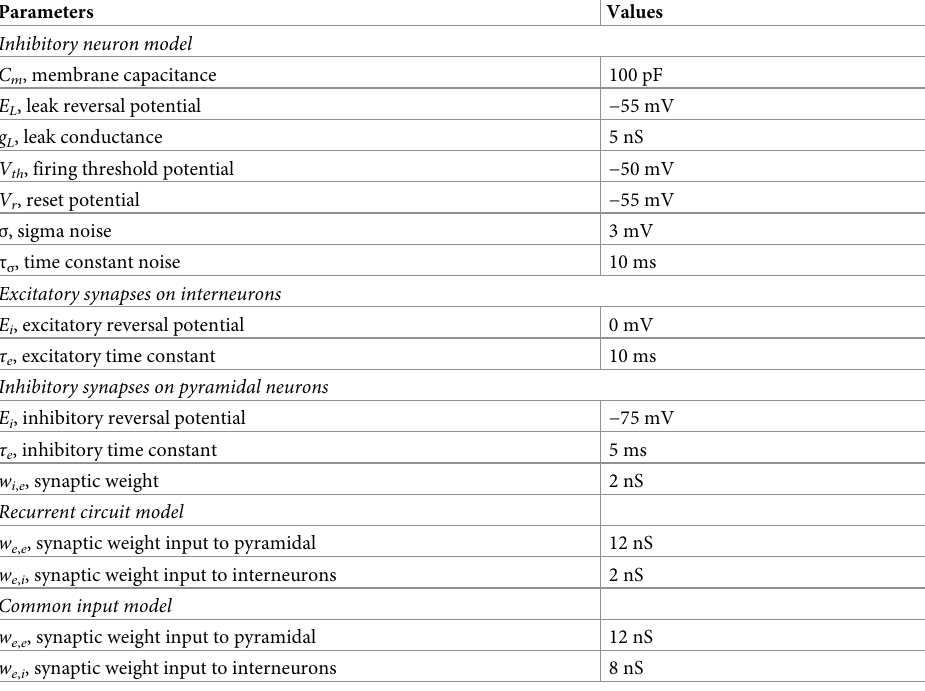
Table 2. Parameters used in models that include inhibitory